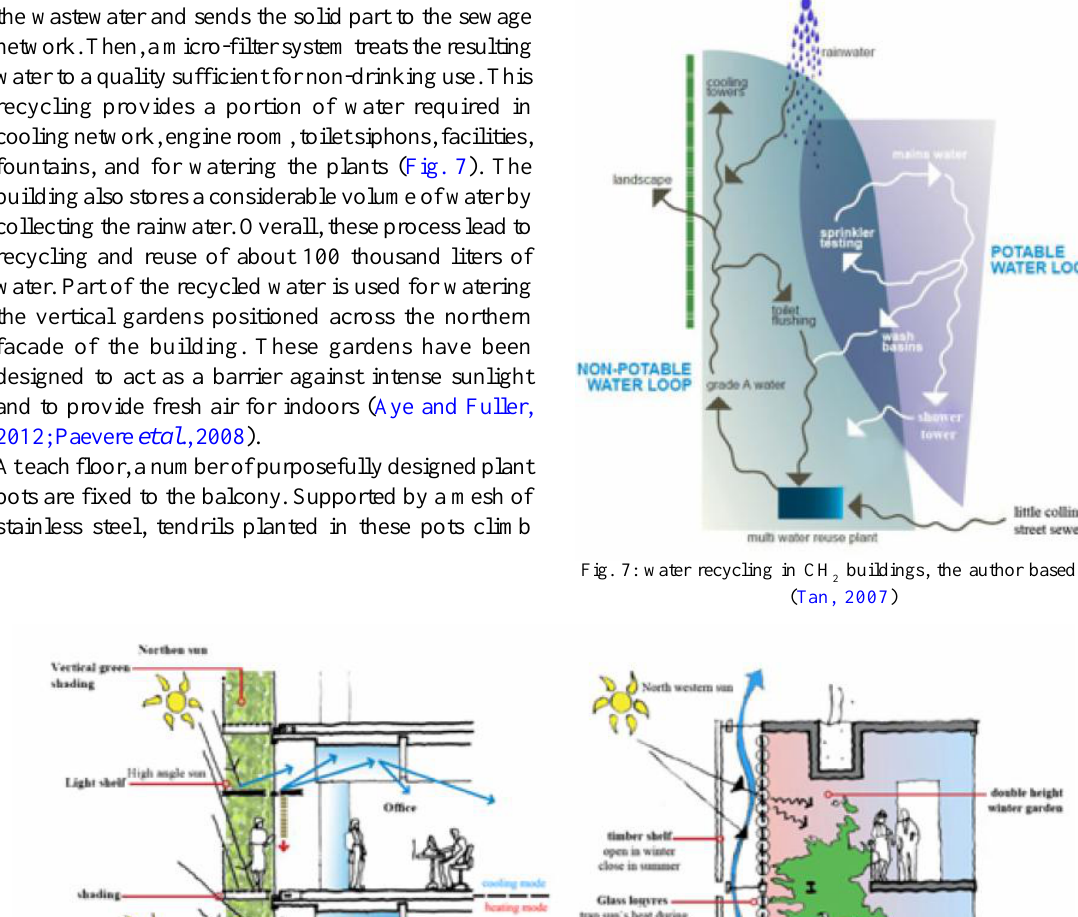
Fig. 8: temperature and sunlight regulation in the northern and western envelop during the course of a year (Tan, 2007)